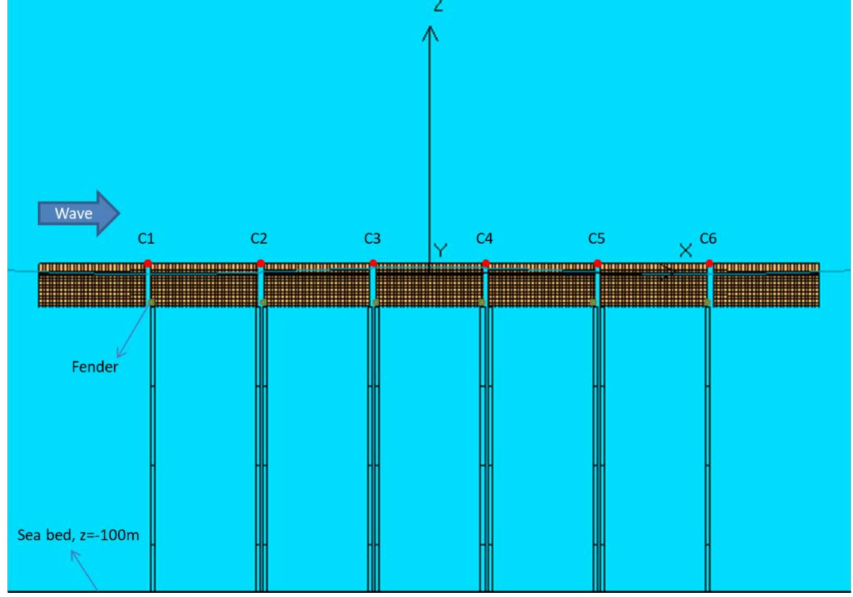
Figure 3. Hydrodynamic model of the simplified 7-module MTLPW